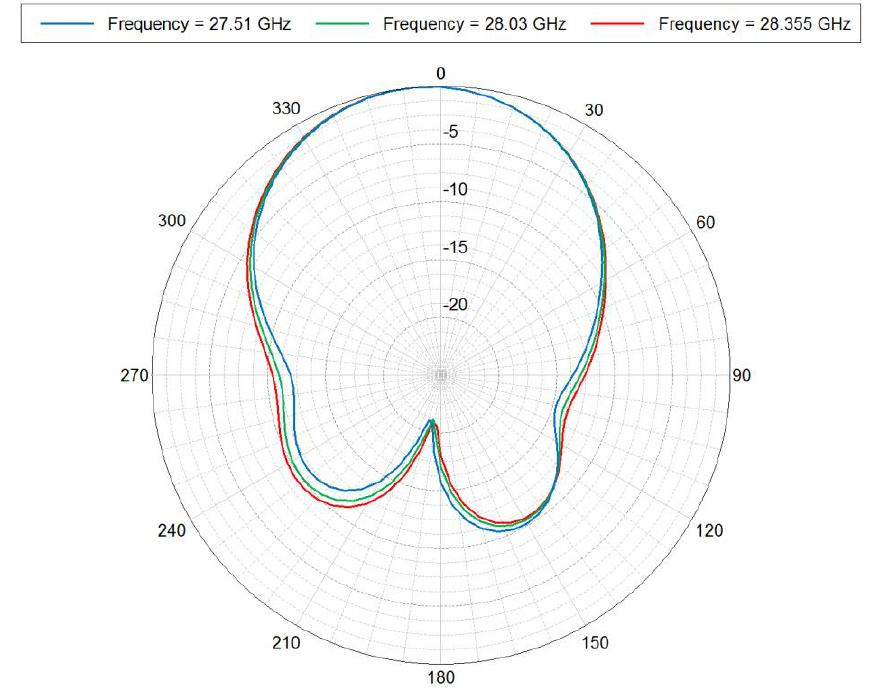
Figure 11. The normalized radiation patterns for the proposed antenna model operating in the 5G system for 27.51 GHz (blue line), 28.0 GHz (green line), and 28.35 GHz (red line) in polar coordinates for vertical polarization.